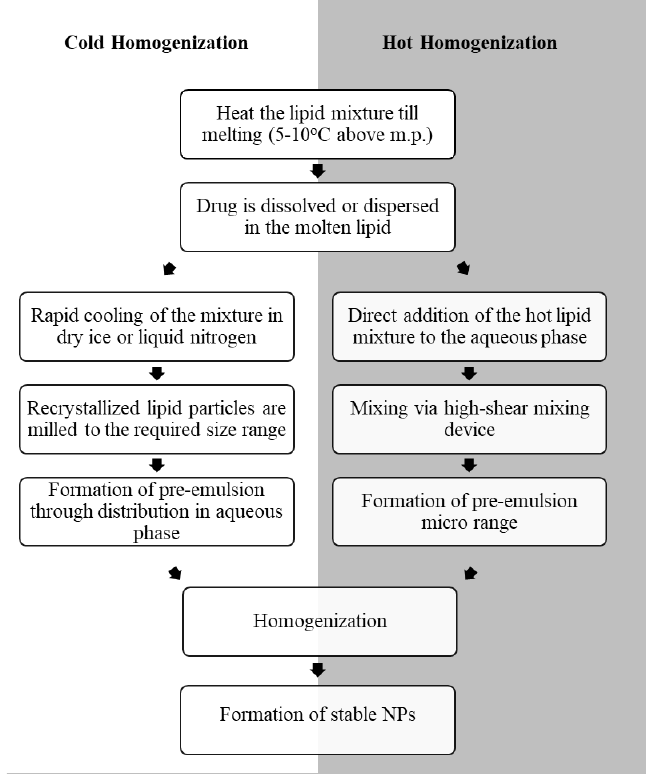
Figure 3. Preparation of NLCs by cold and hot high-shear homogenization.